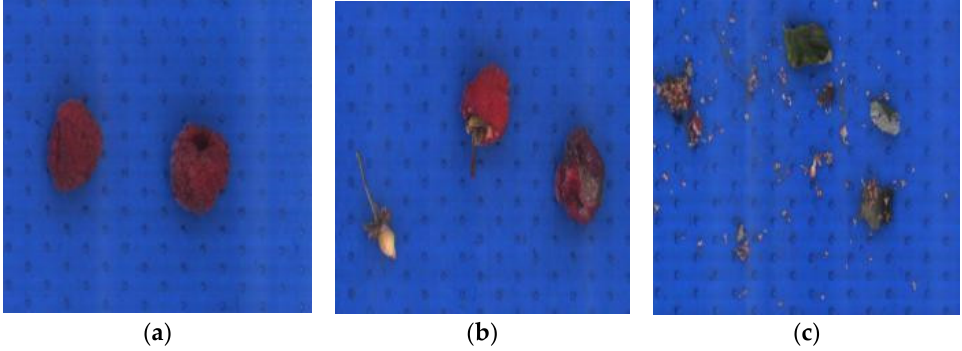
Figure 3. ( a ) Compliant raspberry (class: raspberry), ( b ) noncompliant raspberries (class: stalk, noncompliant, noncompliant + stalk), ( c ) defective materials (class: defect. mat.).